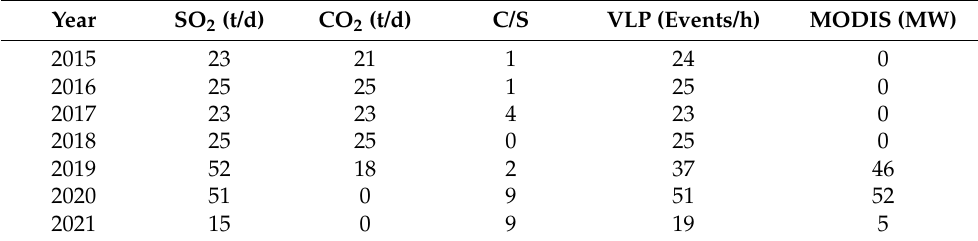
Table 5. Number of parameter–value pairs for the INGV dataset (both weekly and daily).